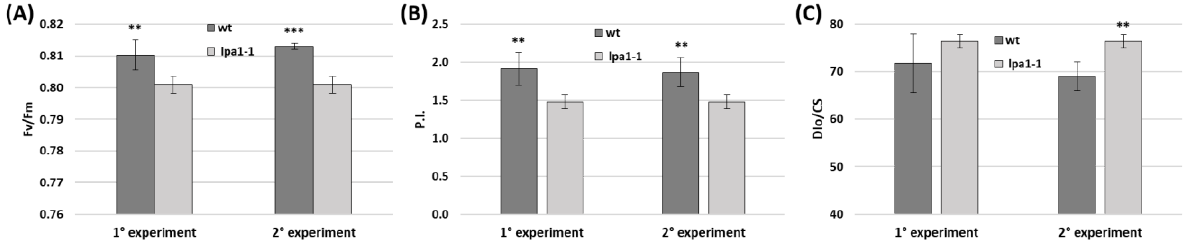
Figure 9. The fluorimeter Handy PEA+ was used to measure Fv/Fm ( A ) and other important photosynthetic parameters, such as the performance index (PI) ( B ) and the energy dissipation of photosystem II (Dio/CS) ( C ). Values represent the mean of three biological replicates. Significant differences between wild-type and lpa1-1 were assessed by Student’s t -test (** p < 0.05 and *** p < 0.01).